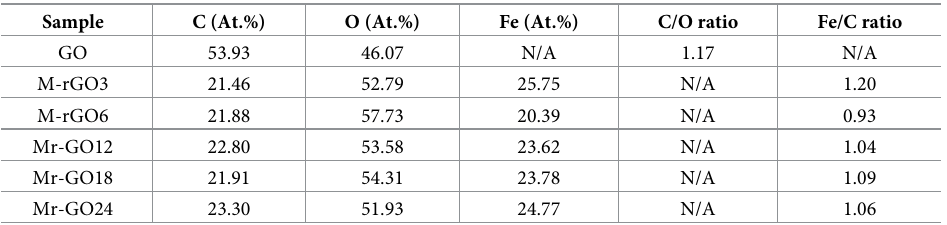
Table 2. EDX analysis (in At.%) of GO and M-rGO nanocomposites. Sample C